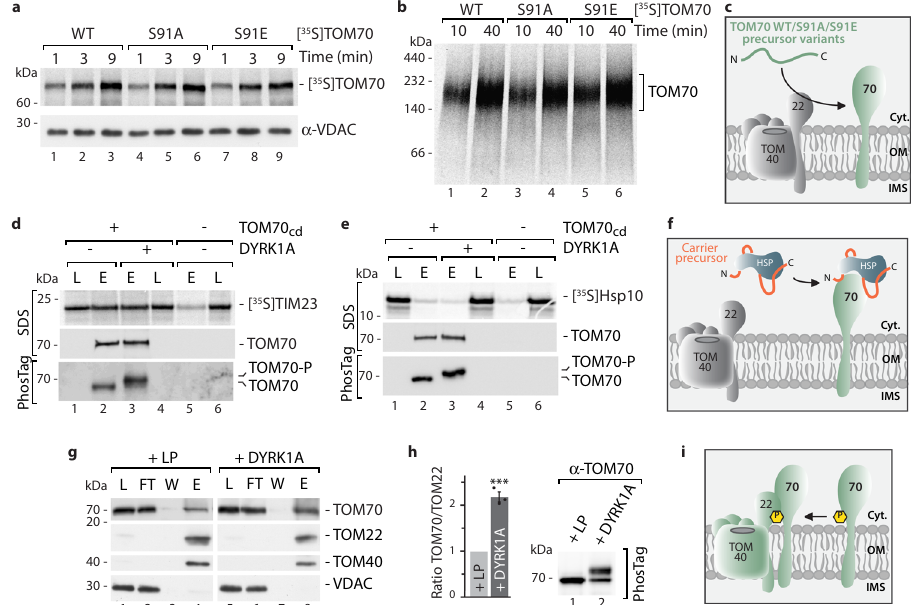
Fig. 4 Analysis of the role of TOM70 Ser91 phosphorylation in the TOM complex. a Indicated [ 35 S]TOM70 precursor variants were imported into isolated mitochondria for indicated time followed by protein extraction in 100 mM sodiumcarbonate (pH 11.5). Carbonate-resistant pellet was loaded on